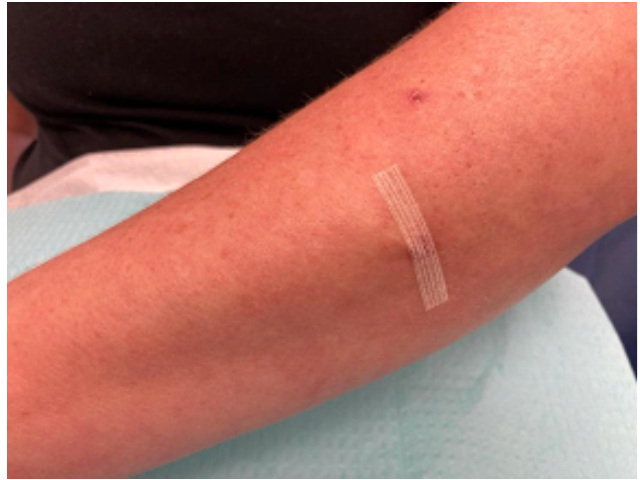
Figure 2 : Left-arm punch biopsy